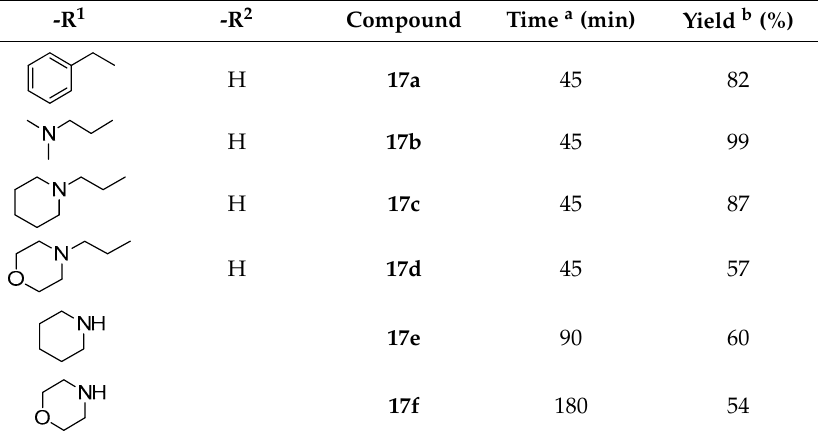
Table 6. Chemical structures and yields obtained for the synthesis of 1 7a – f .